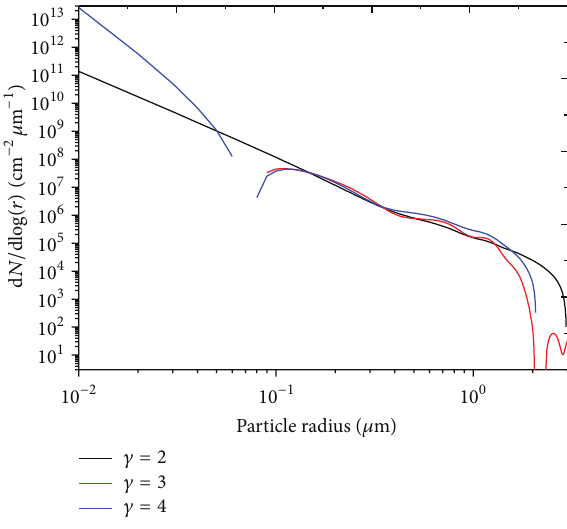
Figure 3: The determination of parameters V of Junge